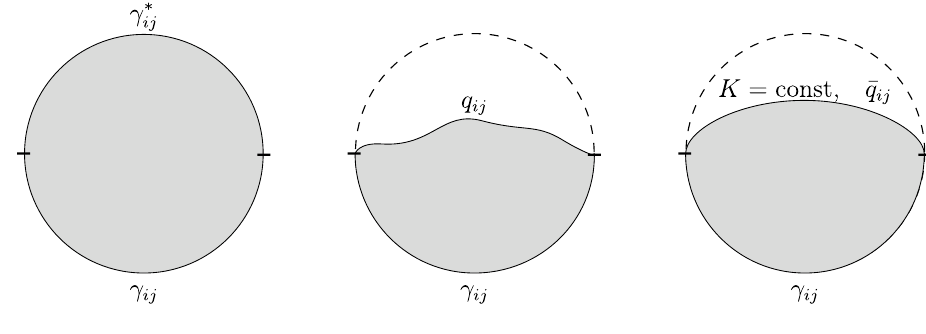
Figure 1 . Three di(cid:11)erent Dirichlet